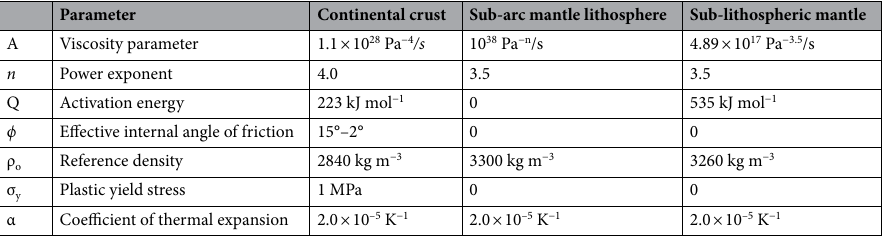
Table 1. Rheological parameters for numerical models: dry olivine mantle 45 , wet quartzite crust 46